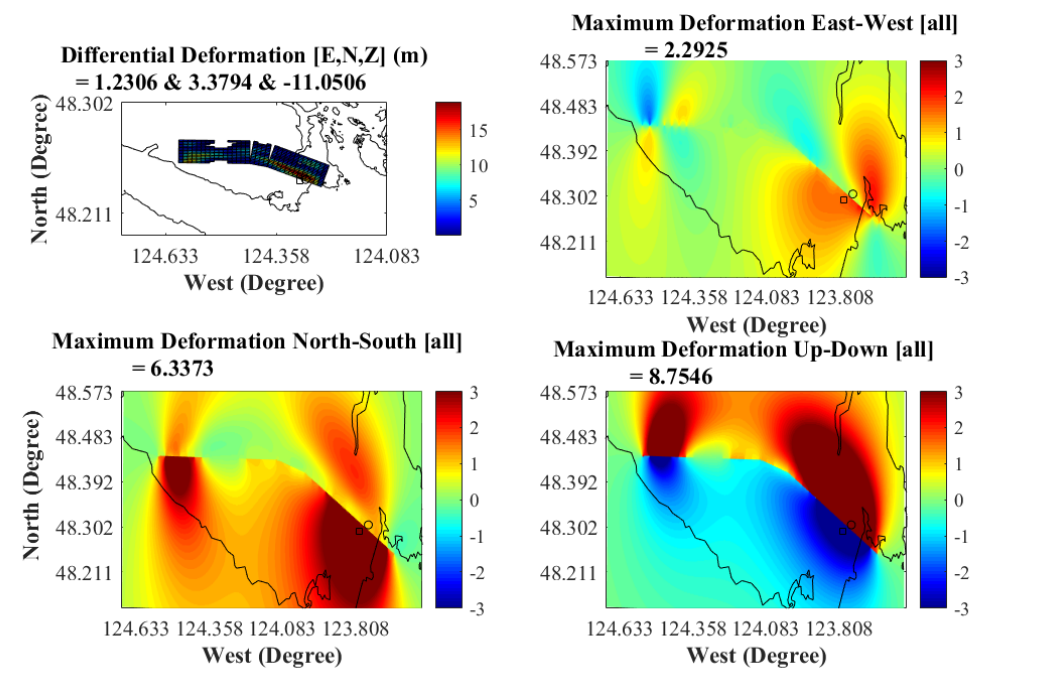
Figure 5. Sample critical rupture scenario slip distribution and regional ground deformation profile in the east–west, north–south and up–down directions in the city of Victoria.